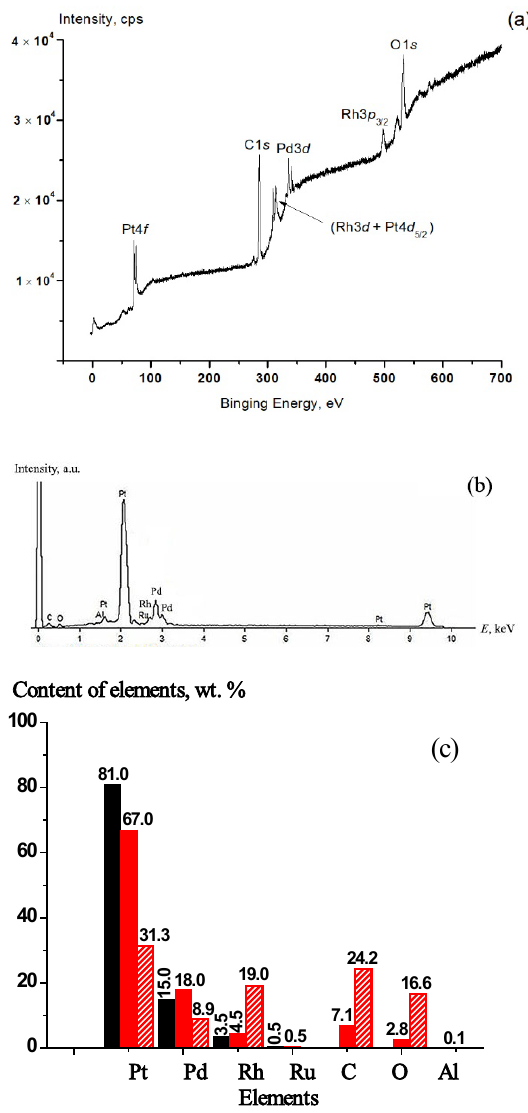
Figure 3. XPS ( a ) and EDS ( b ) spectra obtained for the unused Pt–Pd–Rh–Ru gauze. XPS spectra were recorded on a gauze fragment with the size of 1 × 1 mm and EDS spectra on the wire region with the size of 60 × 200 µm. ( c ) Composition of the new gauze according to the manufacturer data (black left bars) and according to EDS (red central bars) and XPS (shaded right bars) data acquired in this study.